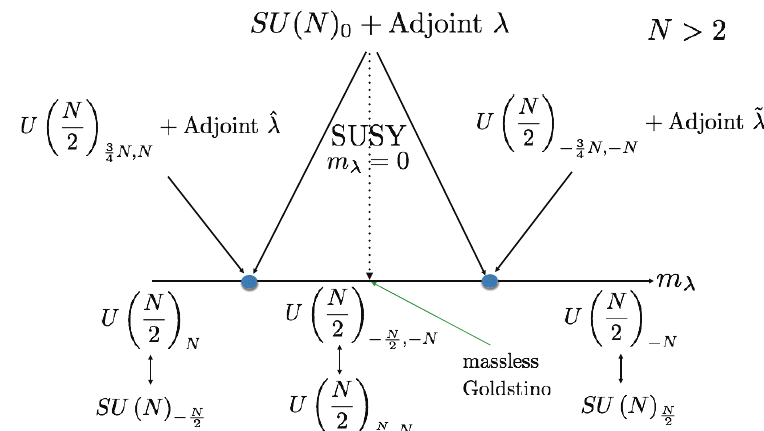
Figure 10: This is the time-reversal invariant theory with an adjoint fermion. The N = 1 supersymmetric point coincides with the time-reversal invariant point. The theory flows to a massless Goldstino and a U ( N / 2 ) N / 2, N